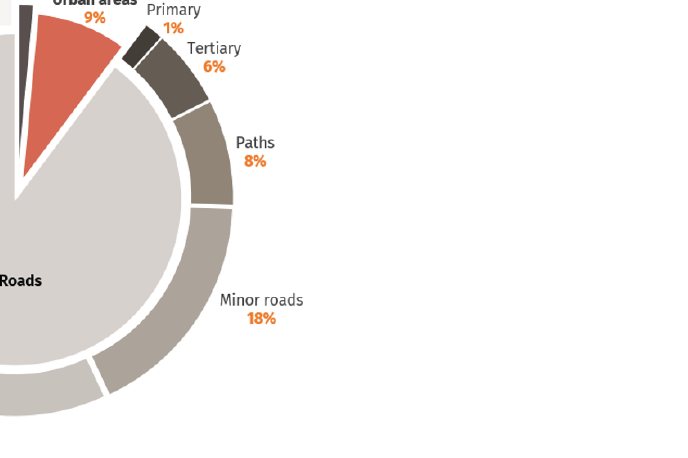
Figure 2. Relative abundance of the fundamental stressors to the detected coastal ponds. Due to their substantial differences, the various road types are made explicit (outer ring).